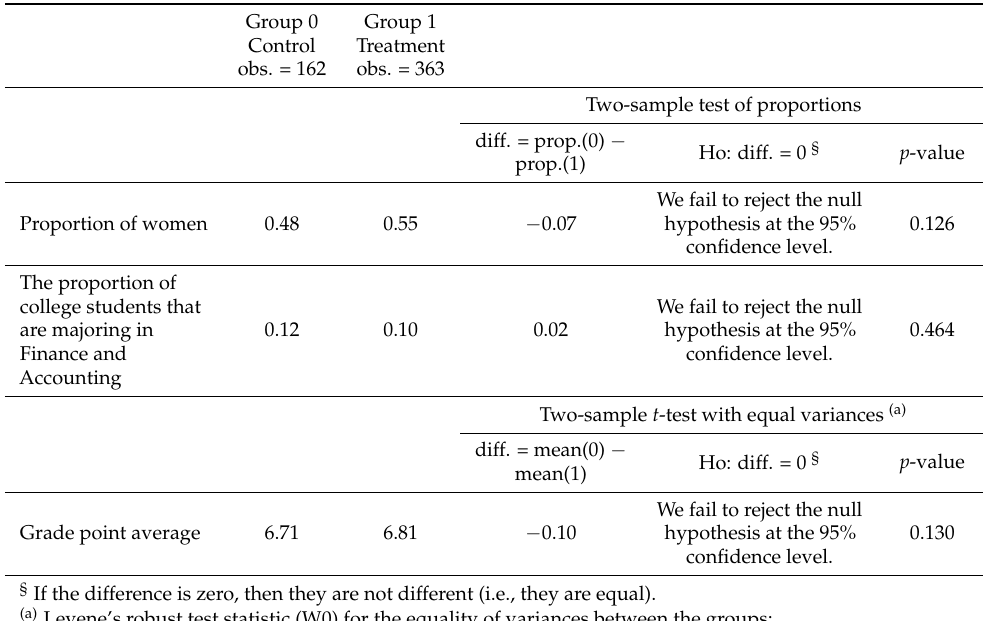
Table A2. Statistical tests for treated and control groups (when experiment participants are grouped into two